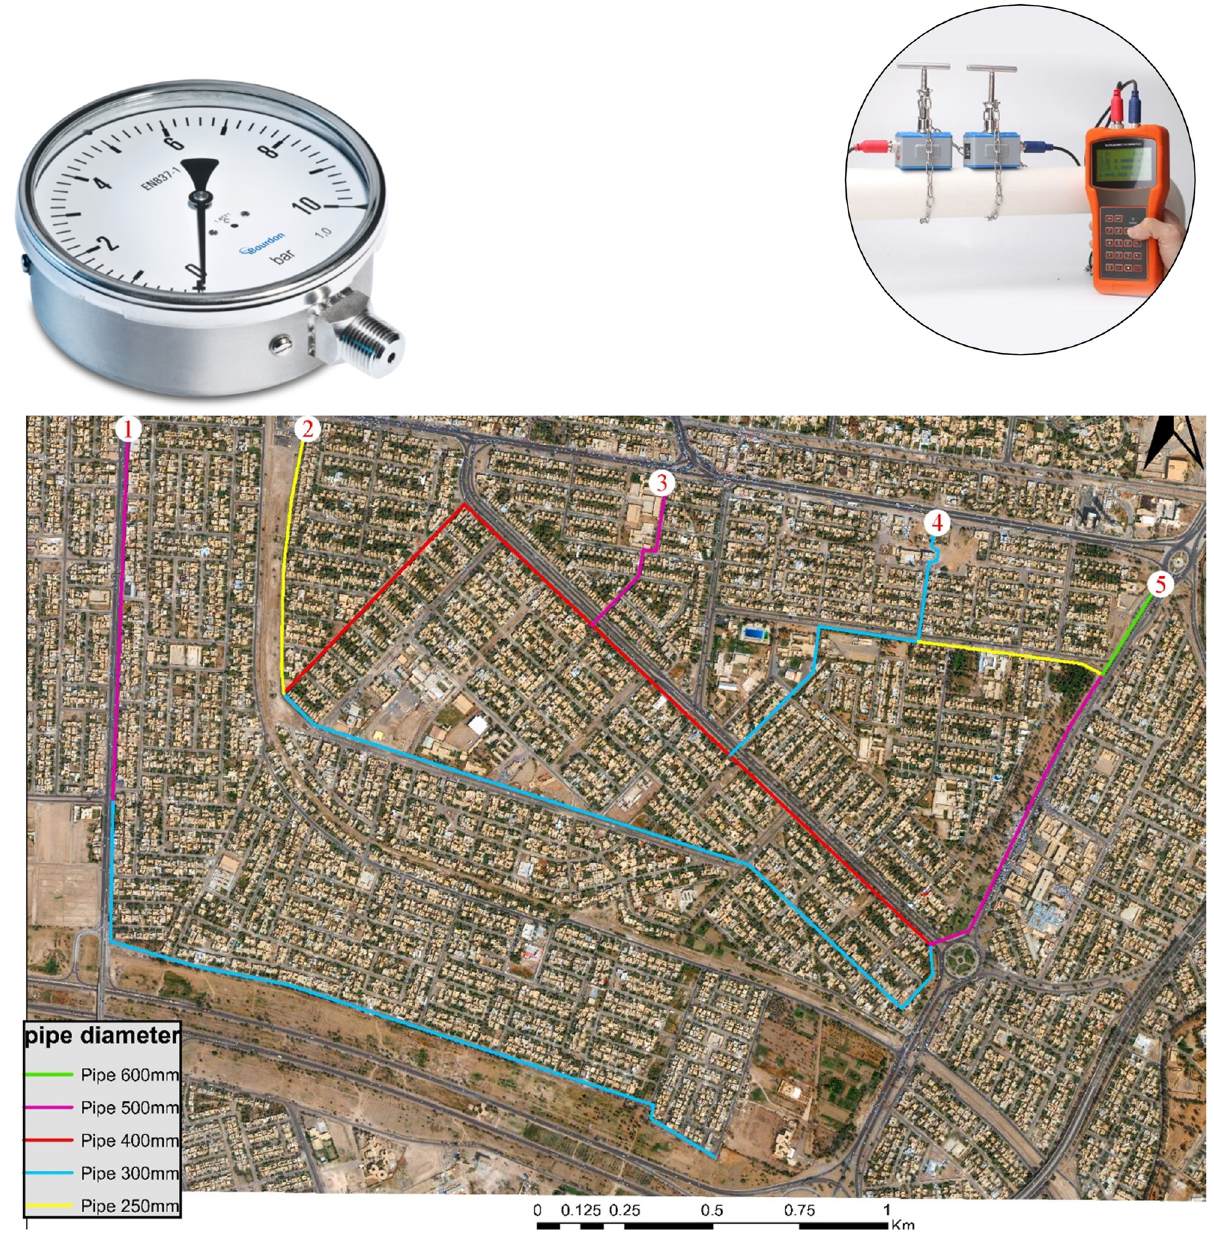
Figure 3: Locations of measuring points and tools